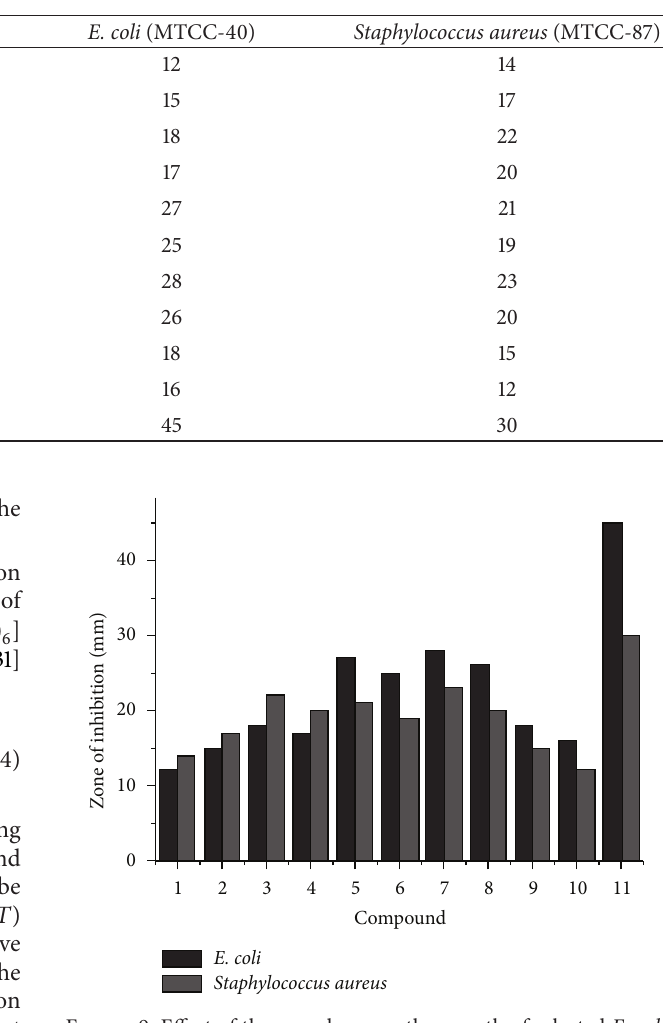
Figure 9: Effect of the complexes on the growth of selected E. coli and S.